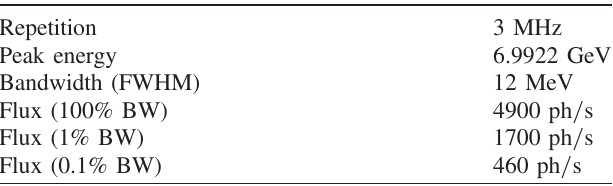
TABLE II. Calculated performance of the XFELO- γ with parameters listed in Table I.